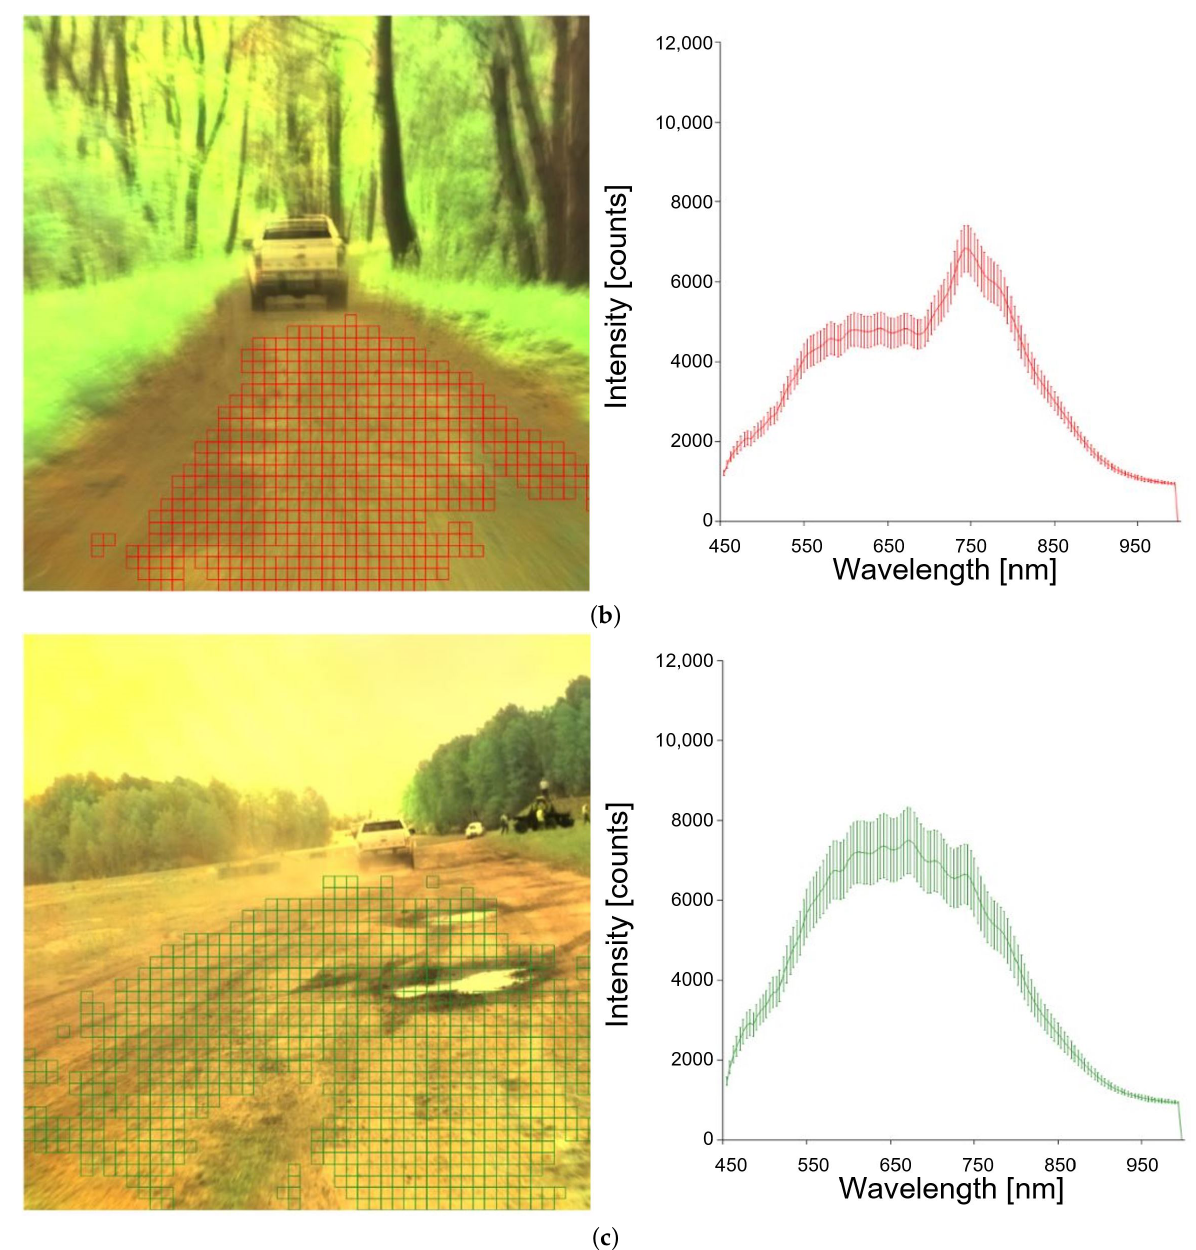
Figure 6. Different types of roads and corresponding spectral response: ( a ) dirt road, ( b ) forest road (land), ( c ) bumpy/mixed road (with